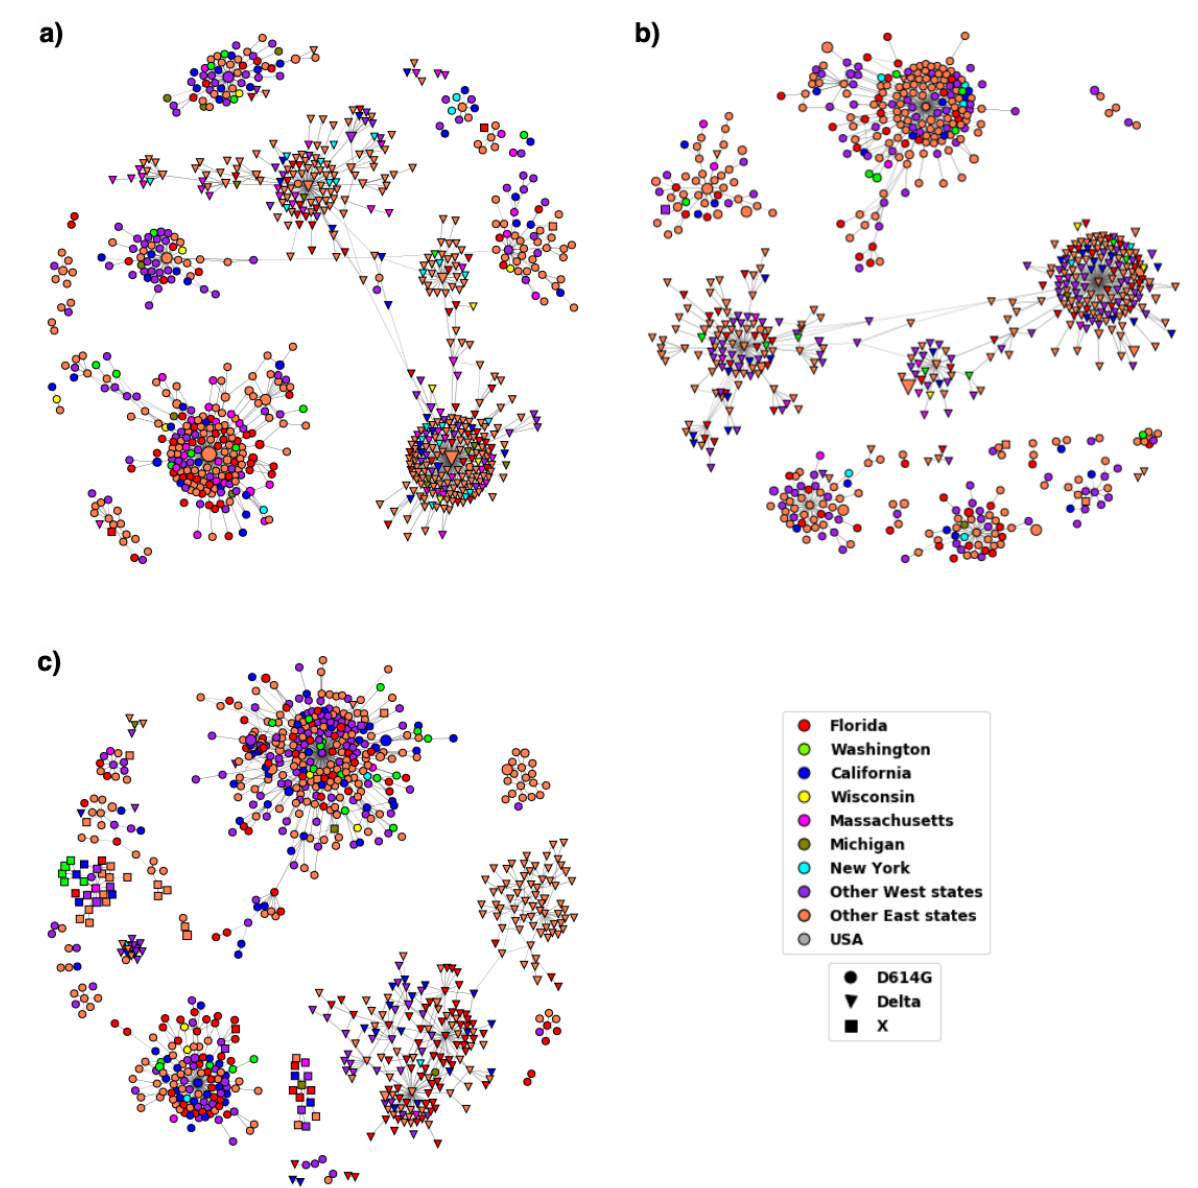
Figure 6. DiWANN networks for the last three time periods T9–T11. ( a ) The network for T9 comprised of 762 nodes, ( b ) T10 comprised of 700 nodes, ( c ) T11 comprised of 786 nodes. The shape of the node corresponds to the variant and the node color to the location as depicted by the legend. Nodes labelled as ‘USA’ did not have location information. The inverted triangular nodes have characteristic Delta variant mutations whereas the circular nodes might have other mutations in the established D614G variant.